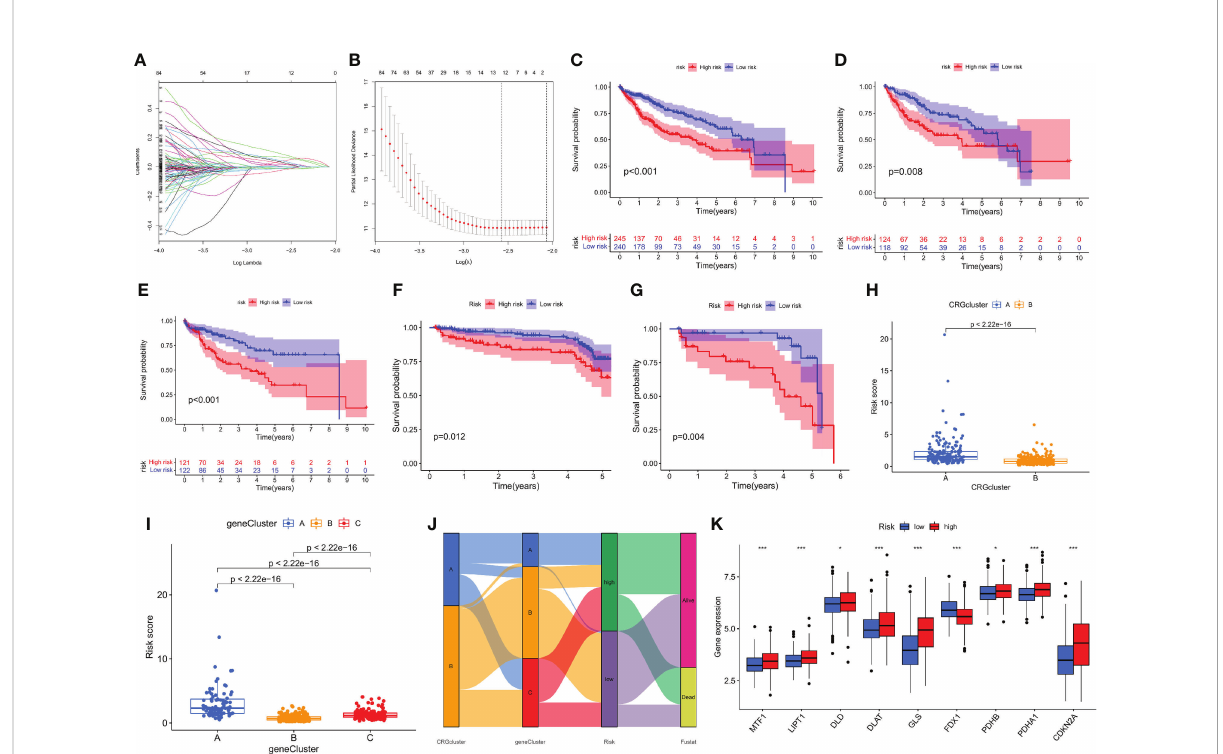
FIGURE 5 Construction of the CMPRG_score. (A, B) The LASSO regression analysis and partial likelihood deviance on the prognostic genes. (C – G) Kaplan – Meier analysis of the OS between the three groups in the all sample, training set, testing set, GSE14520, and GSE116174 cohorts, respectively. (H) Differences in CMPRG_score between pyroptosis subtypes. (I) Differences in CMPRG_score between gene subtypes. (J) Alluvial diagram of subtype distributions in groups with different CMPRG_score and survival outcomes. (K) Differential expression of CRGs at different high and low